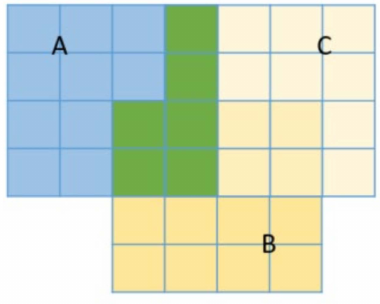
Figure 11. Schematic diagram of ship intersection between simulated frames. A is detection of n frame. B and C are detections of n + 1 frame.